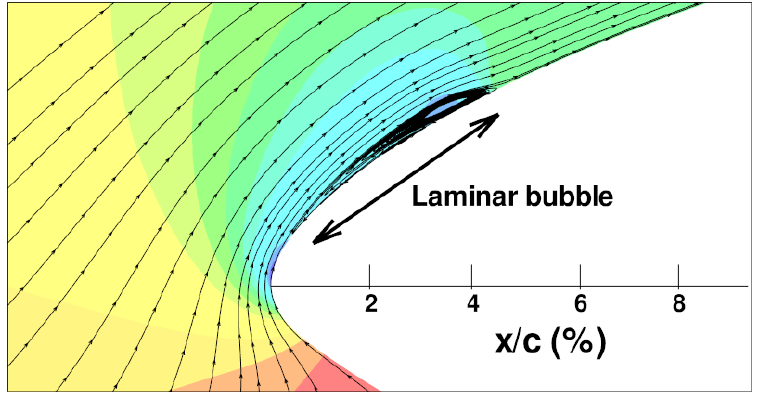
CFD calculation of the S809 airfoil showing occurence of laminar bubble